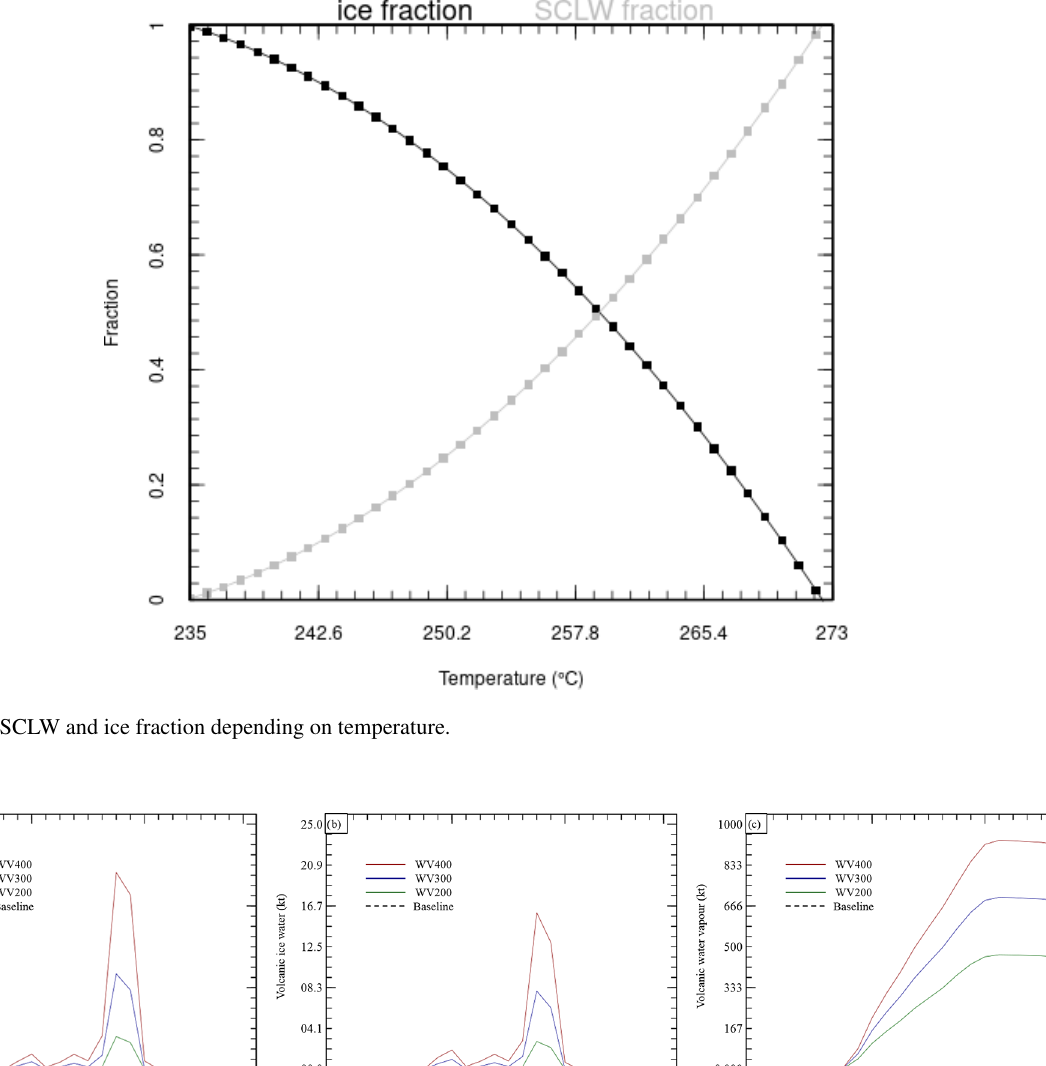
Atmos. Chem. Phys., 22, 13861–13879, 2022